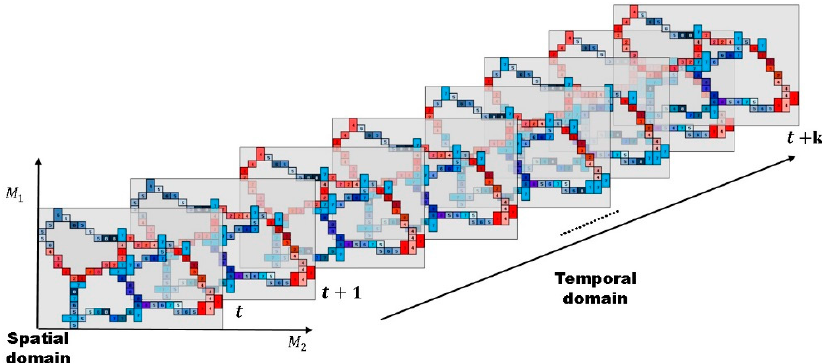
Figure 2. Definition of the 3D heat map: the heat map is defined on the irregular lattice and represents the spatial and temporal correlation of the traffic flow. A cell on the map corresponds to each road (or link, cone-zone), and a different color is assigned to each cell according to its traffic conditions (e.g., speed and density). As can be seen, the cells have similar colors to their spatial and temporal neighbors. Based on these characteristics, we model the traffic flows as 3D MRFs and then estimate the traffic flow at time t + k .